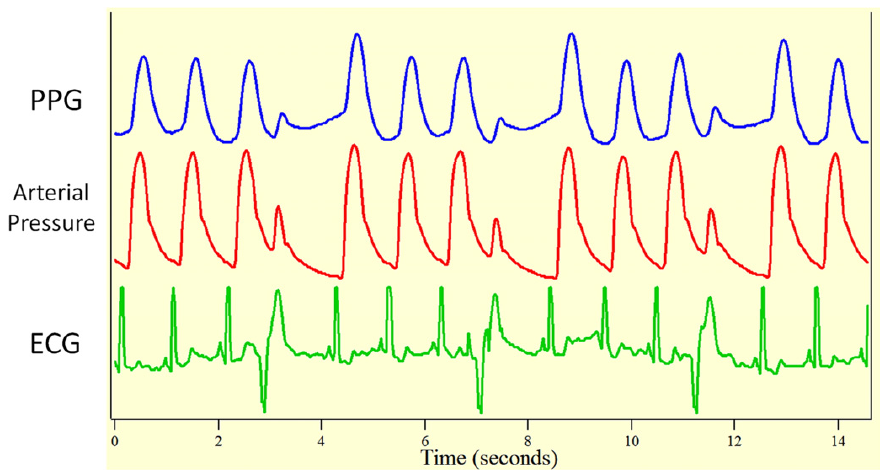
Figure 1. The effect of cardiac arrhythmia (PVCs) on the photoplethysmographic (PPG) waveform. From [15], copyright (2014), with permission from Elsevier.